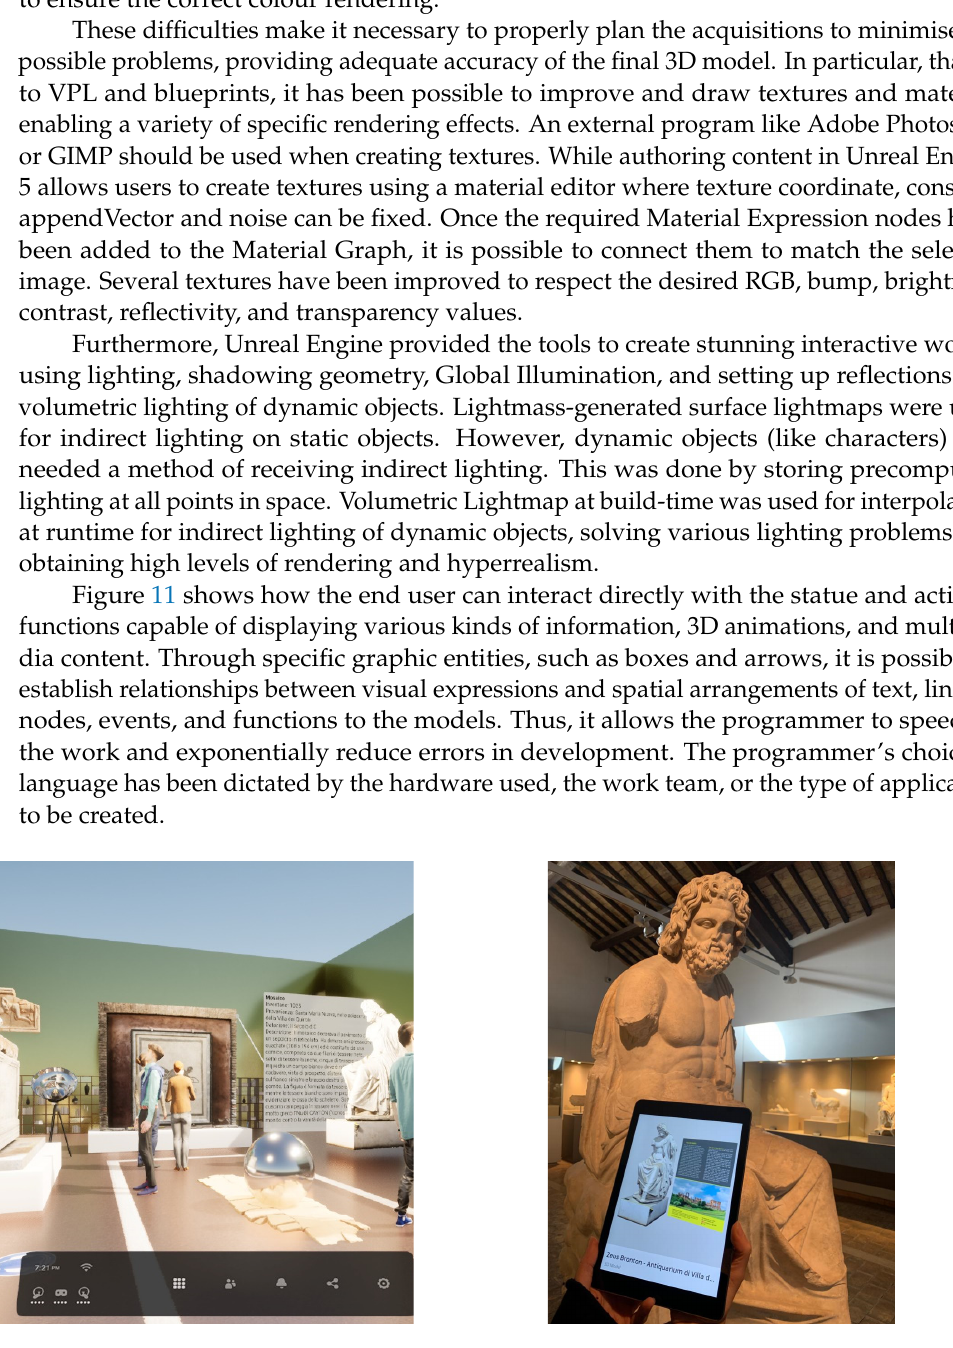
Figure 11. Interactive digital representation, VR, and AR implementation for multiple experiences and devices. and